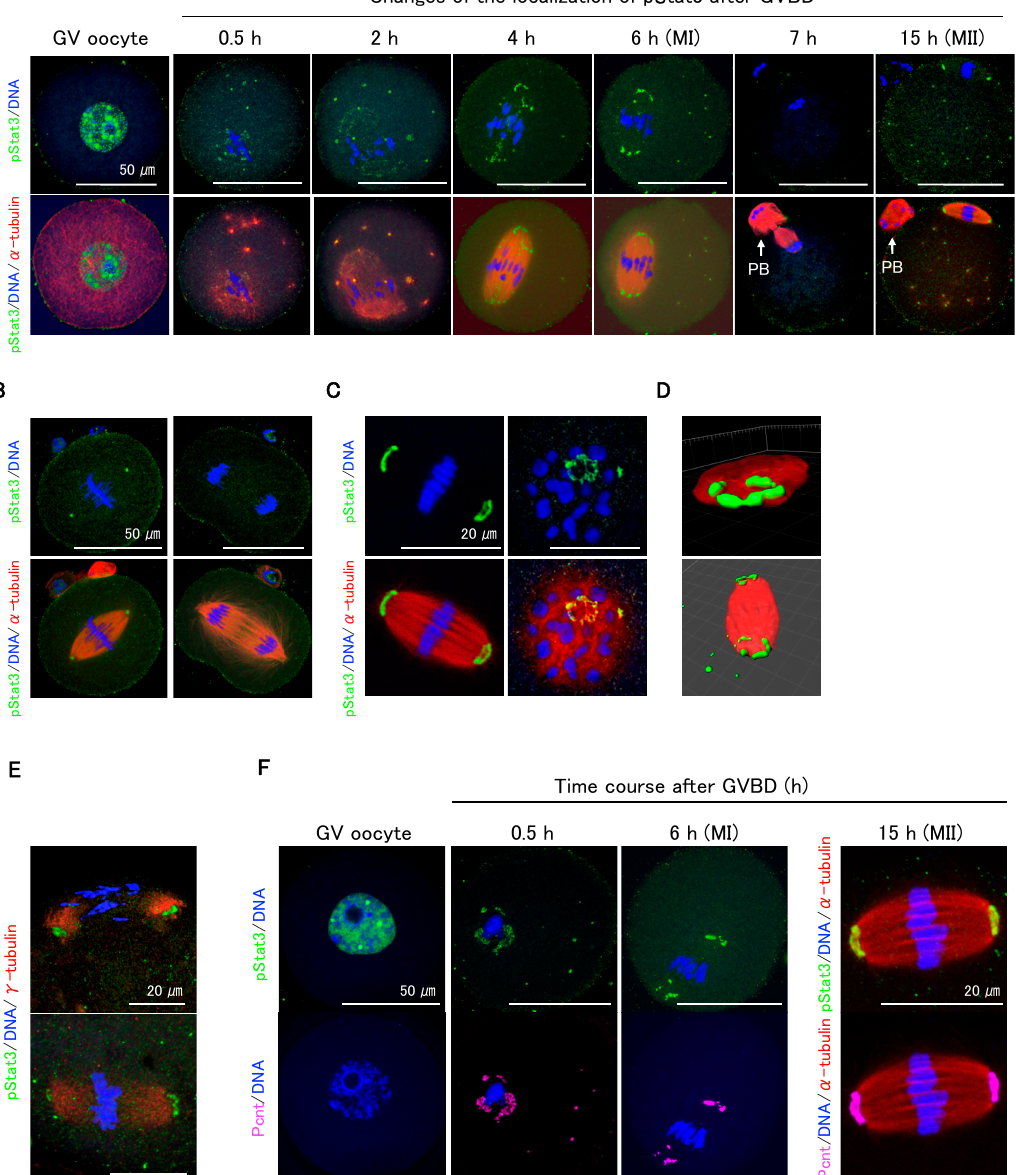
Figure 2. Dynamic changes of pStat3 localization during oocyte maturation. ( A ) Time course observation of pStat3 localization after germinal vesicle break down (GVBD). Immediately after GVBD, the accumulated pStat3 in the GV declines remarkably (0.5 h) and appears at microtubule asters (0.5 h, 2 h, and thereafter). The pStat3 emerges at the spindle (4 h) and microtubule-organizing centers (MTOCs) in the MI spindle (6 h), and it then disappears in the anaphase / telophase (7 h). The pStat3 localizes again at the MTOCs in the MII spindle (15h). Arrows indicate first polar body (PB). ( B ) The pStat3 localizes at the MTOCs in the M-phase (left figures), but not in the telophase (right figures) in the 1-cell stage. ( C ) The pStat3 exhibits a ring-shape at the MTOCs. The right-hand figures are views from the MTOC. ( D ) The ring-shape localization of pStat3 was also confirmed by a reconstructed 3D image with Imaris software 8.4. ( E ) pStat3 co-localizes with γ -tubulin at MTOCs in the MI (upper figure) and MII spindles (lower figure). The γ -tubulin exhibits a di ff used pattern of expression. ( F ) Though pericentrin (Pcnt) is not detected in the GV, it emerges after GVBD and co-localizes with pStat3 during maturation. Di ff erent colors indicate pStat3 (green), α -tublin or γ -tublin (red), pericentrin (magenta), and DNA